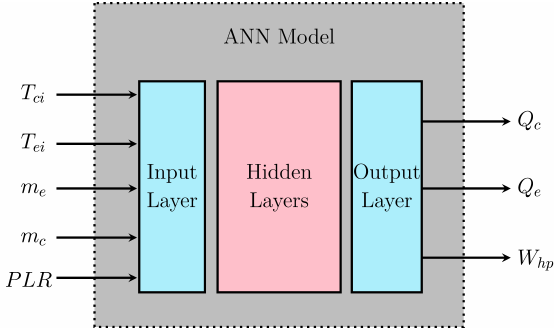
Figure 4. Schematic diagram of the artificial neuron